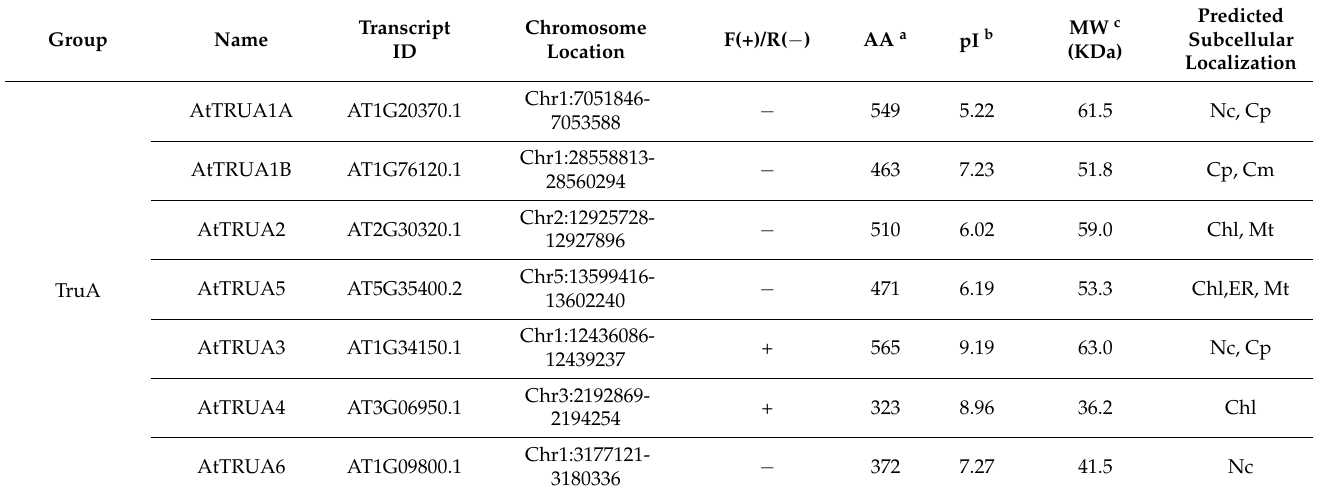
Table 1. Information of AtPUS genes and the predicted proteins in Arabidopsis